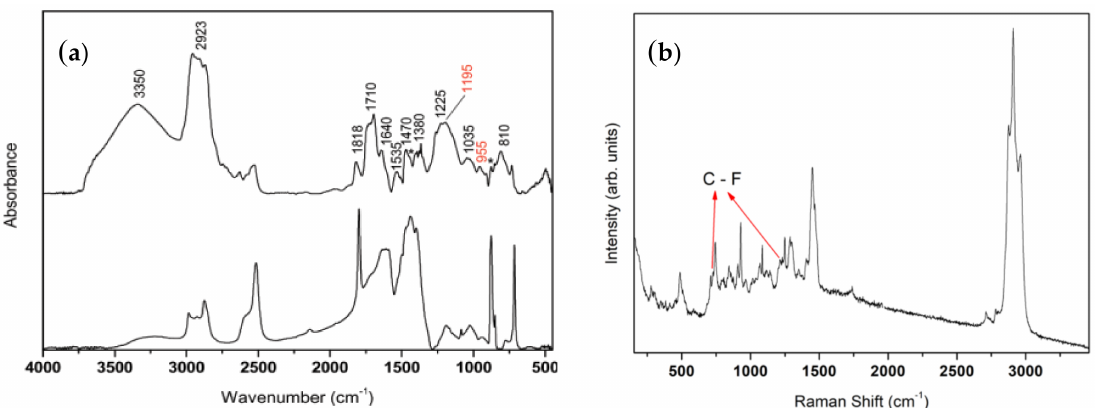
Figure 1. ( a ) FT-IR spectra of bare, uncoated marble (bottom) and marble coated by Silres (top). The peaks marked with an asterisk (*) are a result of the marble substrate. ( b ) Raman spectrum of Silres on